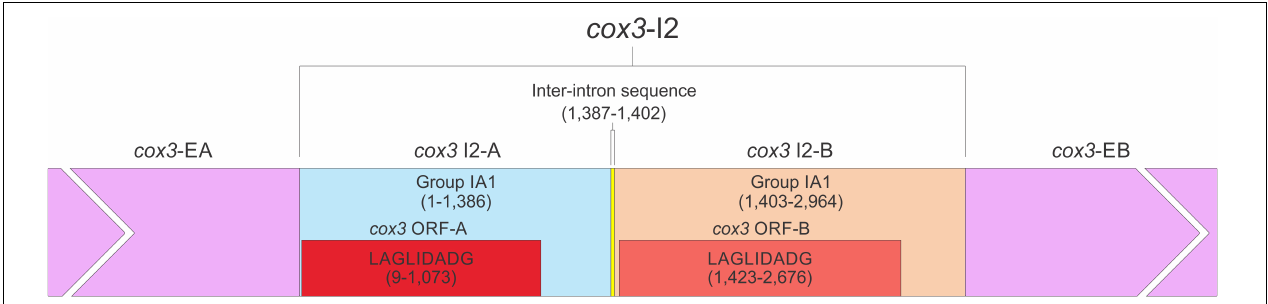
FIGURE 11 | The cox3 –640 intron schematic diagram. cox3 i2, the entire complex intron at cox3– 640 position. cox3 i2-A, cox3 i2’s upstream group IA intron; cox3 -EA, upstream exon; cox3 ORF-A, cox3 i2-A’s ORF; cox3 i2-B, cox3 i2’s downstream group IA intron; cox3 ORF-B, cox3 i2-B’s ORF; cox3 -EB, downstream exon. Inter-intron sequence: sequence separating cox3 i2-A and cox3 i2-B. LAGLIDADG designation represents the type of homing endonuclease ORF encoded by group I introns. The numbers in brackets represent the position and length of each intron element relative to the start of cox3